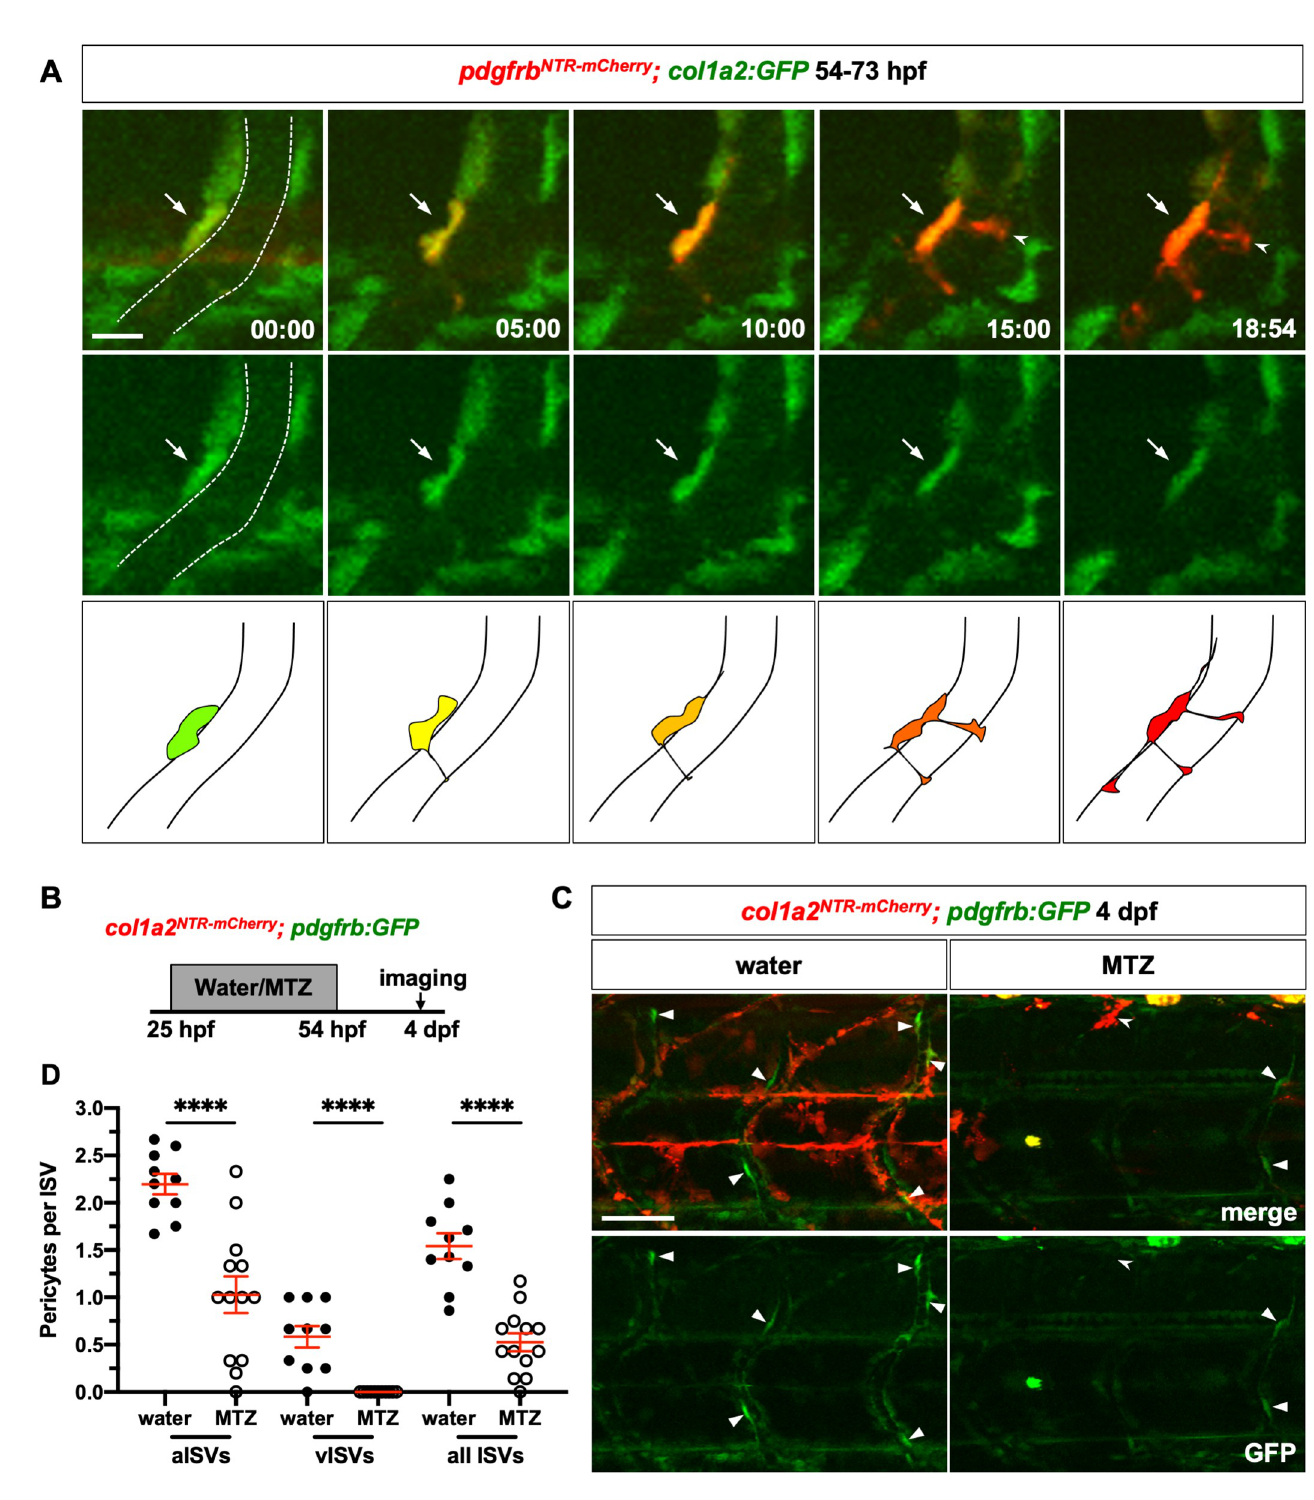
Fig 4. Perivascular fibroblasts function as pericyte progenitors. (A) Snapshots from time-lapse imaging of pdgfrb NTR-mCherry ; col1a2 : GFP embryos from 54 to 73 hpf. Newly differentiated pericytes were retrospectively traced to identify their cell of origin. The ISV is outlined by dotted lines at the first time point. One perivascular fibroblast (green, arrows) traced can be seen gradually upregulating pdgfrb NTR-mCherry expression and extending pericyte-like cellular processes (notched arrowheads).